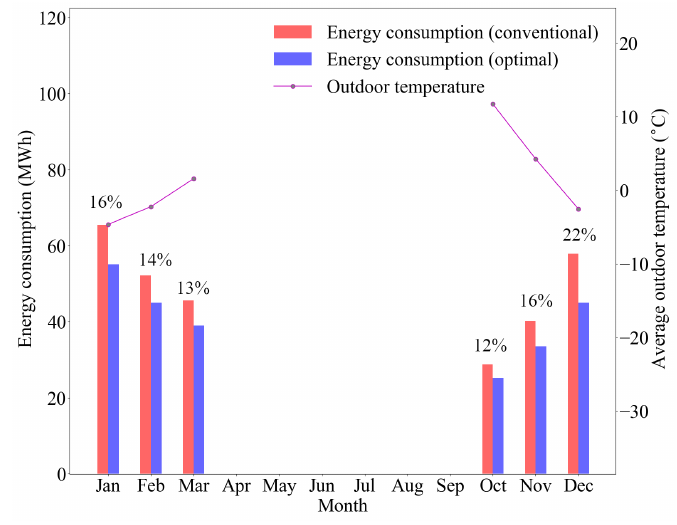
Figure 13. Comparison of monthly energy consumption for